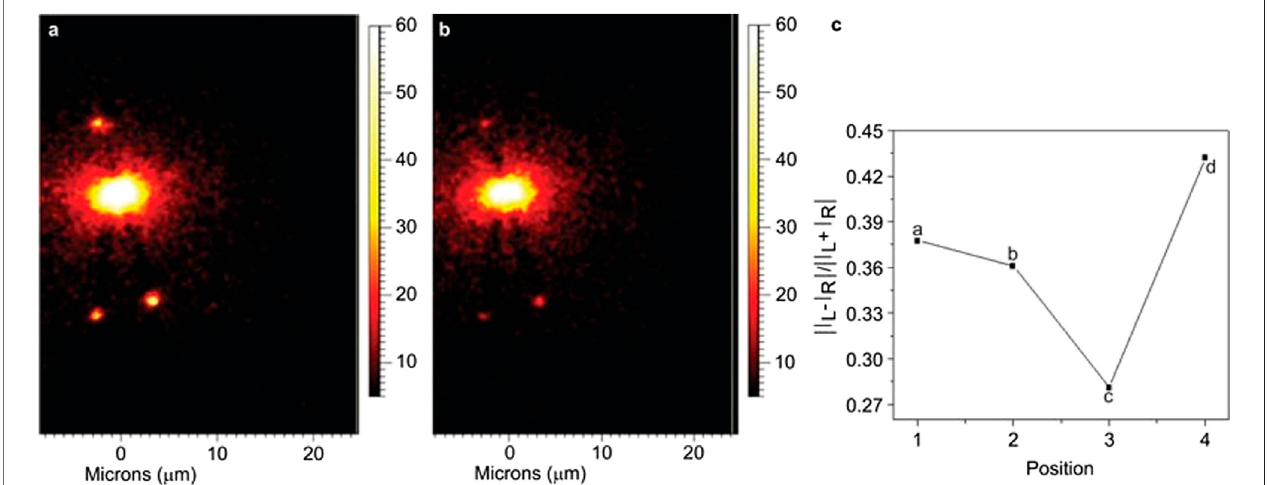
FIGURE 7 | Imaging of the Raman peak of FGGO at 1593 cm − 1 , excited by circular polarization, and the fi tted CIDs at four different points. (A) Results for left circularpolarization. (B) Resultsforrightcircularpolarization. (C) The fi ttedCIDsatfourpointsofthenanostructure.CID,circularintensitydifference;FGGO,fmoc-glycyl- glycine-OH. The fi gure has been adapted with permission from Sun et al., (2013), 2013 CIOMP.